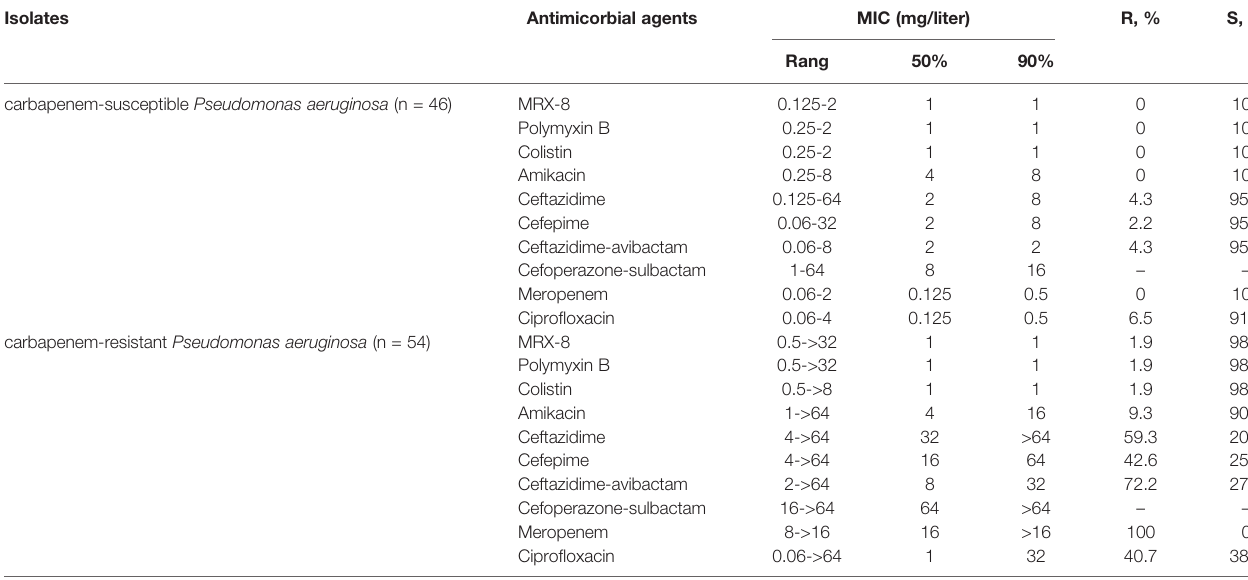
carbapenem-susceptible Pseudomonas aeruginosa (n =